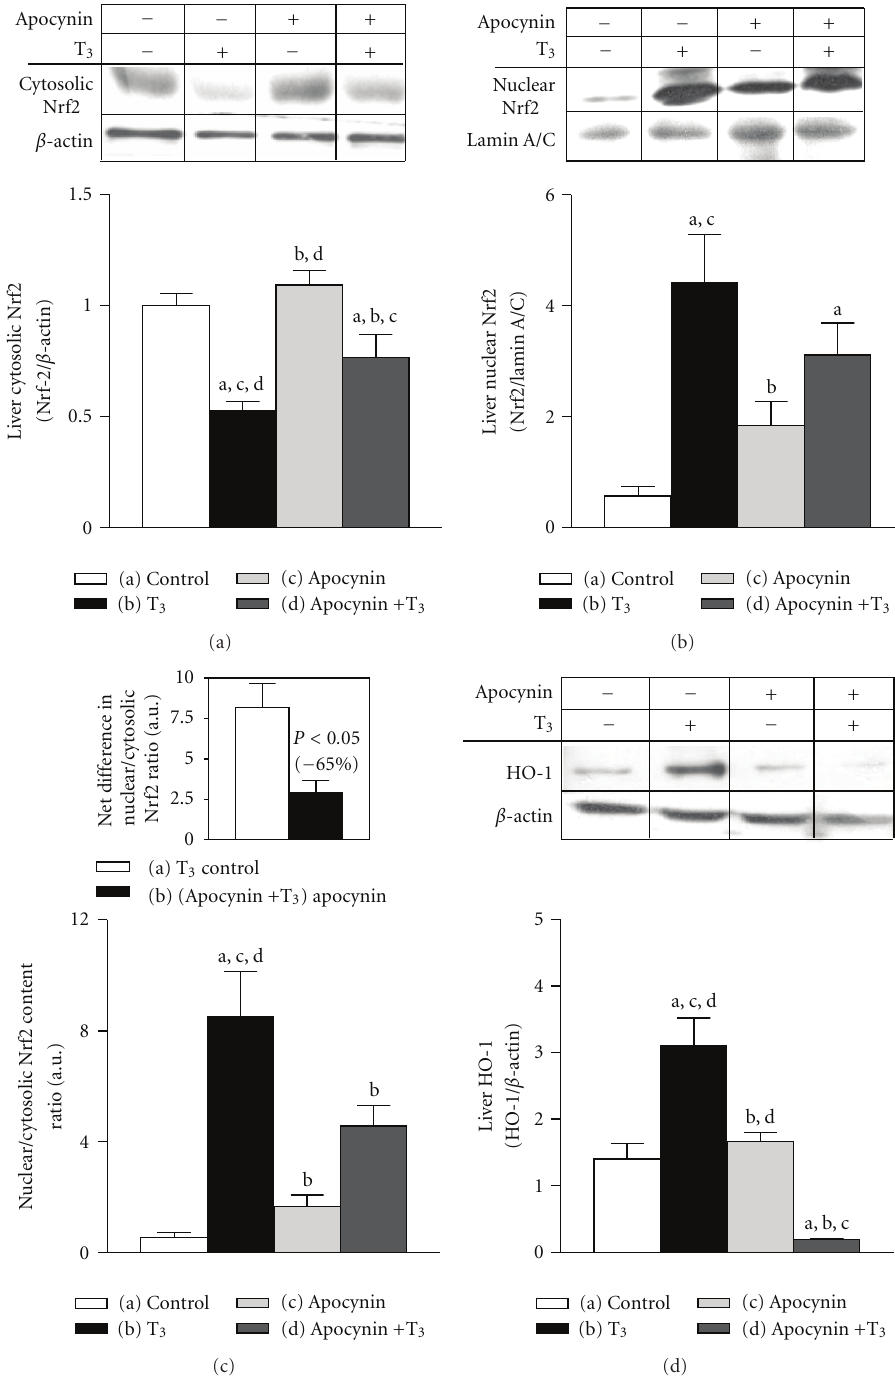
Figure 5: Apocynin administration is associated with diminution of T 3 -induced activation of liver Nrf2 signaling. Determinations were performed at 2h after T 3 administration in rats pretreated with apocynin for 7 days. (a) Levels of cytosolic Nrf2 protein (68kDa) and β - actin (43kDa); (b) levels of nuclear Nrf2 protein and lamin A/C (65kDa); (c) nuclear/cytosolic Nrf2 content ratios and net e ff ects of T 3 and apocynin treatments ( inset ); (d) levels of heme oxygenase 1 (HO-1) protein (33kDa). Values shown represent means ± SEM for 3 to 4 rats per experimental group. Significance ( P < 0 . 05; two-way ANOVA and the Newman-Keuls’ test) is indicated by the letters identifying each experimental group. Significance in the inset of (c) was calculated by Student’s t -test for unpaired